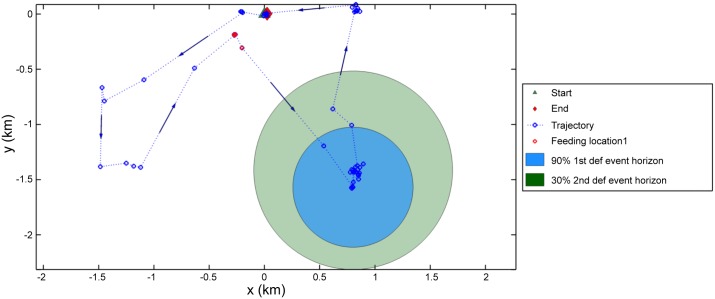
Seed shadow plot from one feeding event.Sample trajectory with one single feeding event (12 hours: 18.00h-06.00h). The spatio-temporal data (GPS fixes in blue) have been plotted at the same resolutions as recorded. The start and end points of the trajectory have been marked (the roost at 0,0 km) as well as the first and subsequent defecation event horizons. Notice that the two circles are not concentric. Concentric circles would appear only if the individual would have returned at time T2 at the same location where it was estimated to be at time T1.